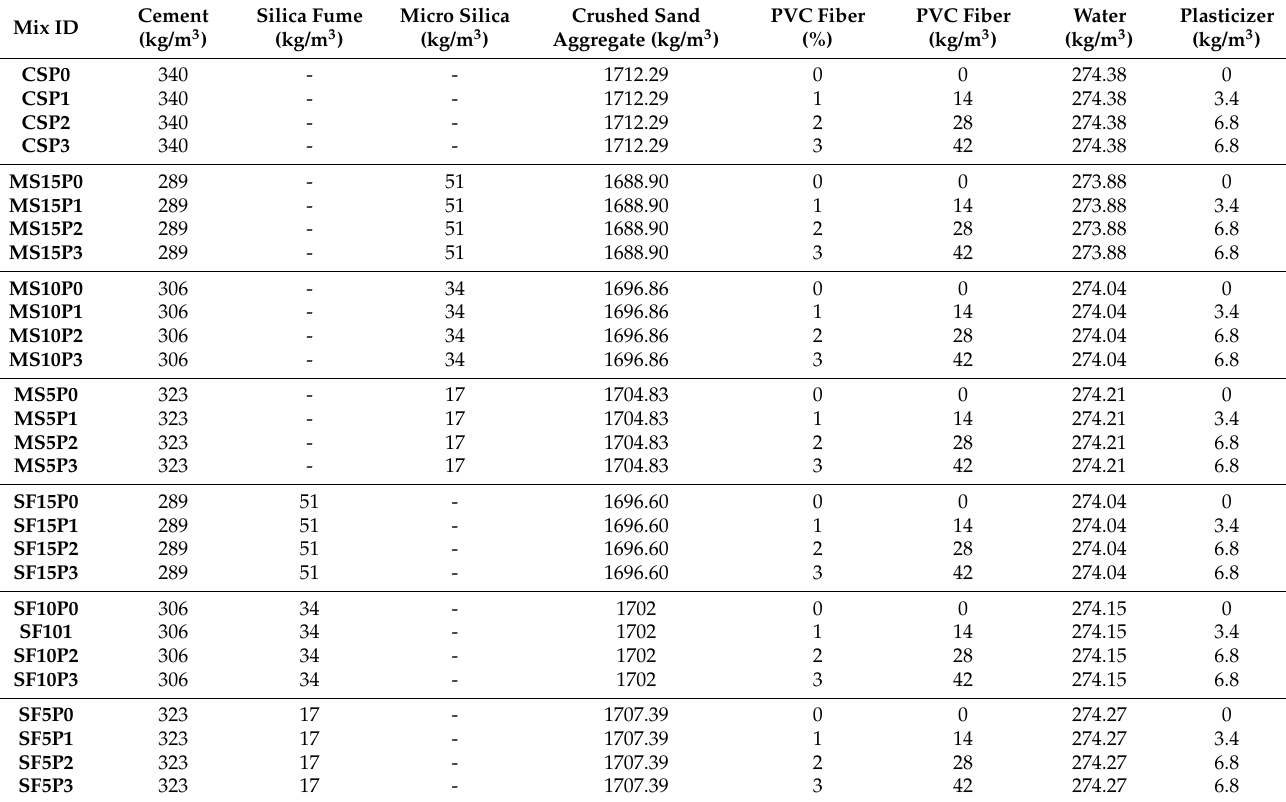
Table 3. Mix proportions used in the manufacturing of